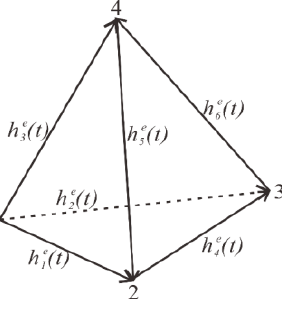
Figure 3. The structural diagram of tetrahedral